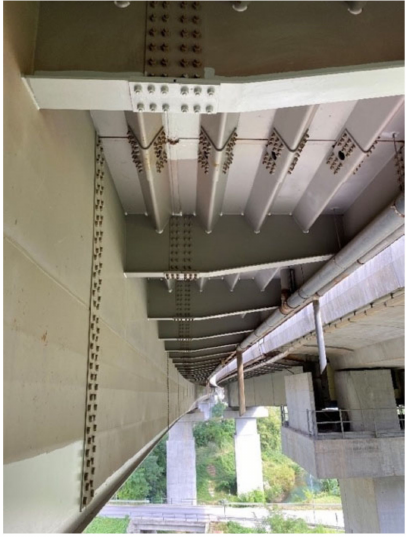
Figure 13. View of the right cantilever of the deck of the case study.